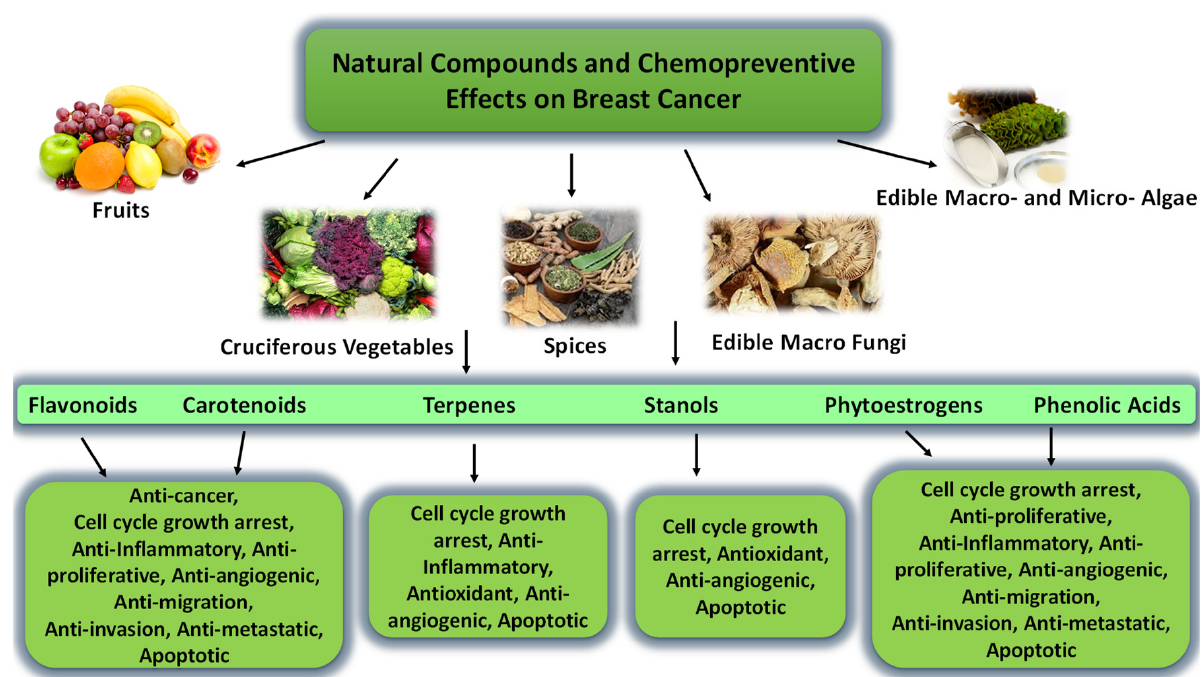
Figure 1. Natural compounds and their chemopreventive effects on cancer.